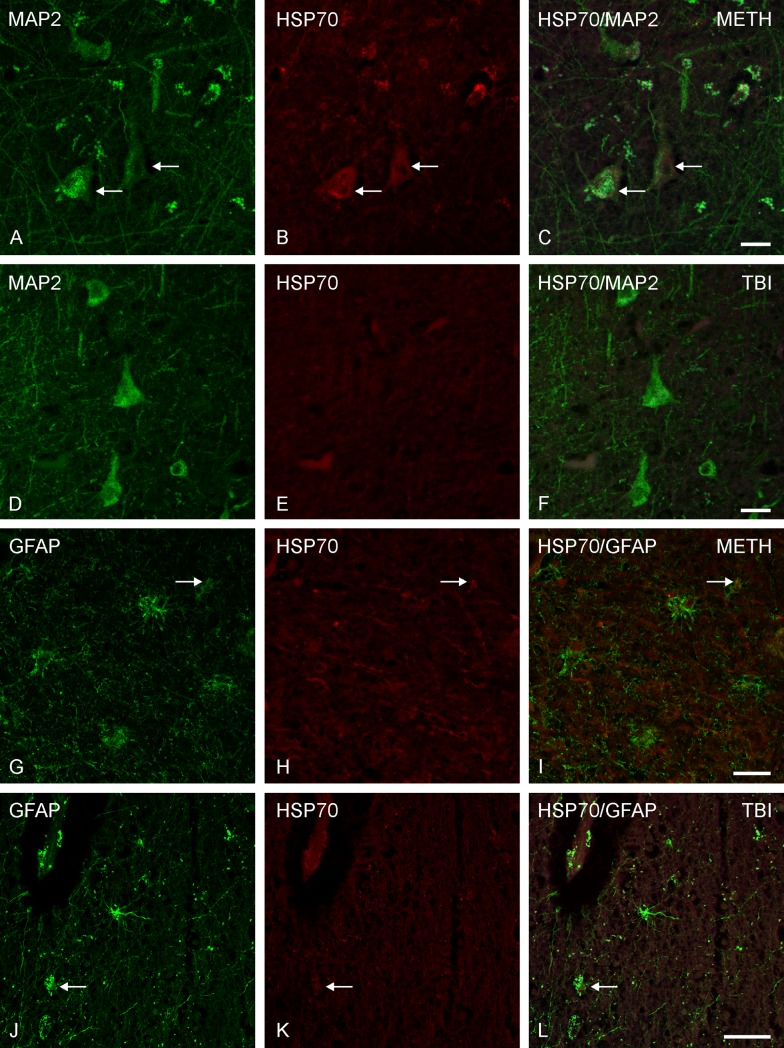
Double immunofluorescence in brain cortex samples.Representative HSP70-positive stained neurons and astrocytes in brain cortex samples using immunofluorescence methods with confocal microscopy. (A-C) Two HSP70 and MAP2 positive multipolar neurons (arrows) with double labeling; (G-I) One astrocytic double labeling of HSP70 and GFAP (arrow); both rows: Methamphetamine (METH)-associated death, scale bar: 20 μm. (D-F) No neuronal co-expression of MAP2 and HSP70. The cause of death was traumatic brain injury (TBI), scale bar: 20 μm. (J-L) Weak double labeled astrocyte by GFAP and HSP70 (arrow). TBI case, scale bar: 50 μm.